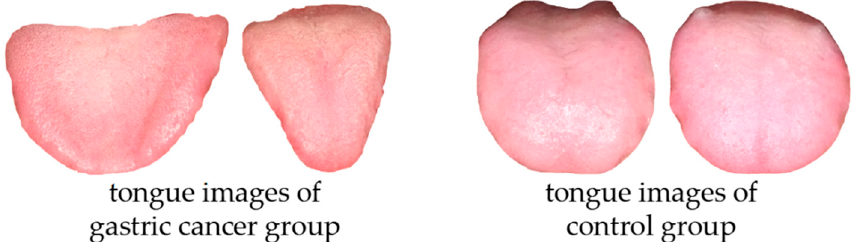
Figure 8. Tongue images in the test set, Image 1 and Image 2 belong in the tongue images of gastric cancer group; Image 3 and Image 4 belong in the tongue images of control group.